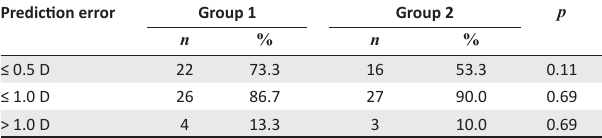
TABLE 2: Deviation of refractive outcome from predicted (target) refraction (absolute values).